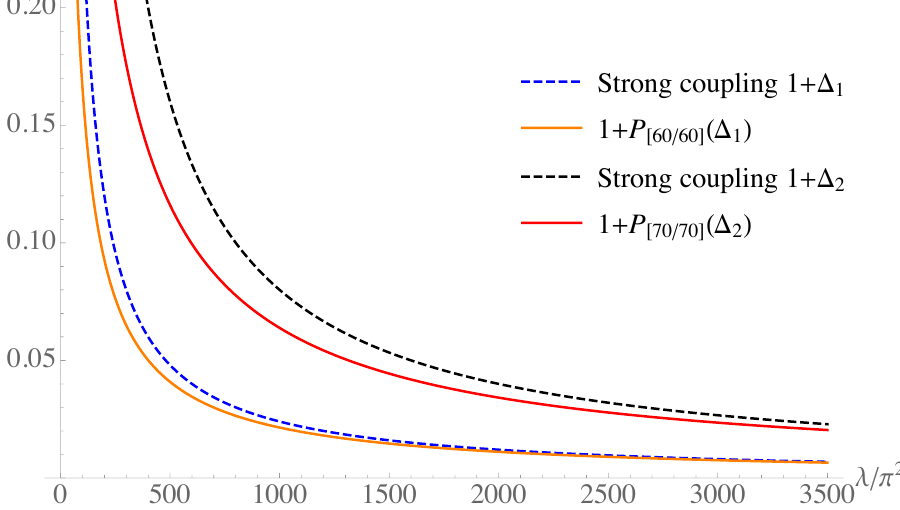
(∆ 1 ) (orange curve), the Padé curve [60 / 60]